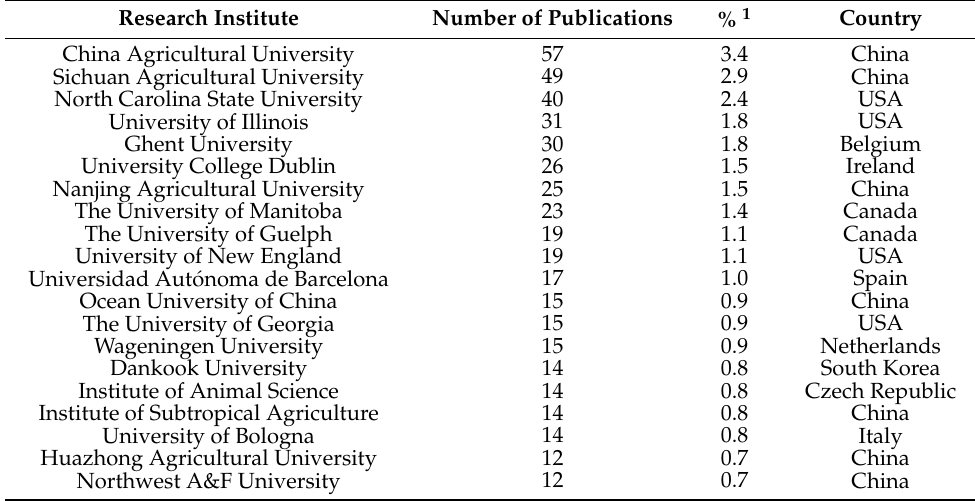
Table 4. Top 20 most productive research institutes sorted by number of